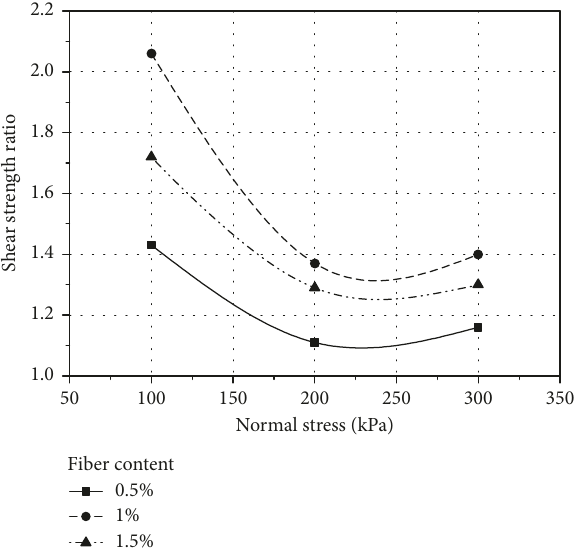
Figure 7: Peak shear strength ratios versus normal stress.